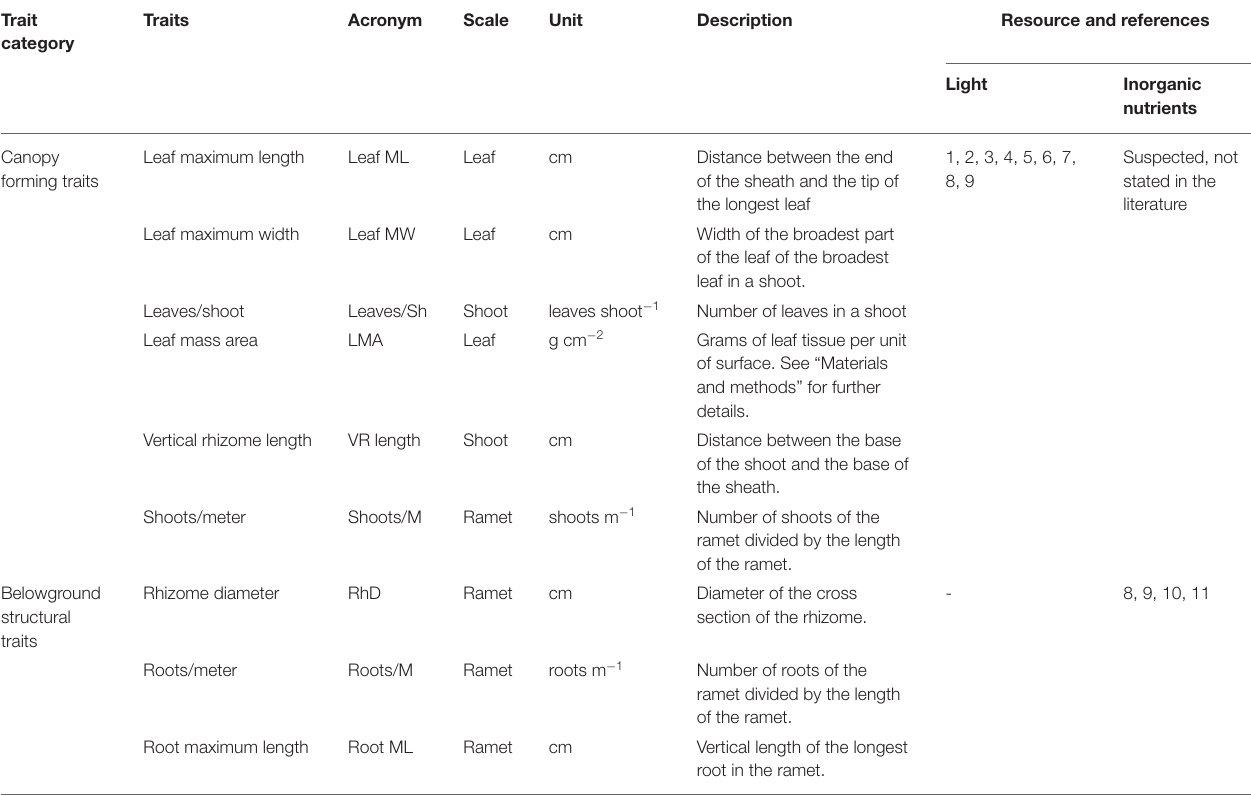
TABLE 1 | Measured traits in relation to the preemptable resource they are connected to. Trait